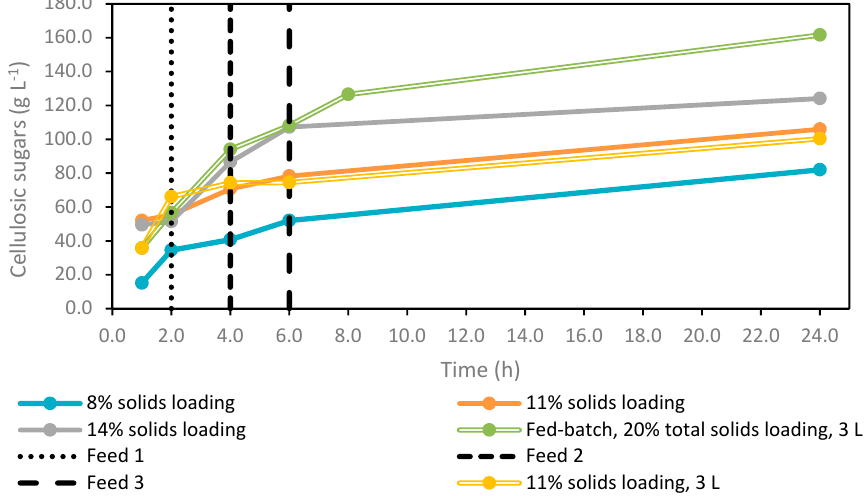
Figure 2. Profile of cellulosic sugars concentrations (g L − 1 ) for enzymatic hydrolysis experiments with 8, 11, 14 and 20% (w/v) solids loading. Enzymatic hydrolysis experiments using a 3 L working volume are represented with a double line, whereas the remaining experiments were carried out using a 1 L working volume. Intermittent feedings of kraft pulp during the fed-batch assay are signalled by dashed lines.